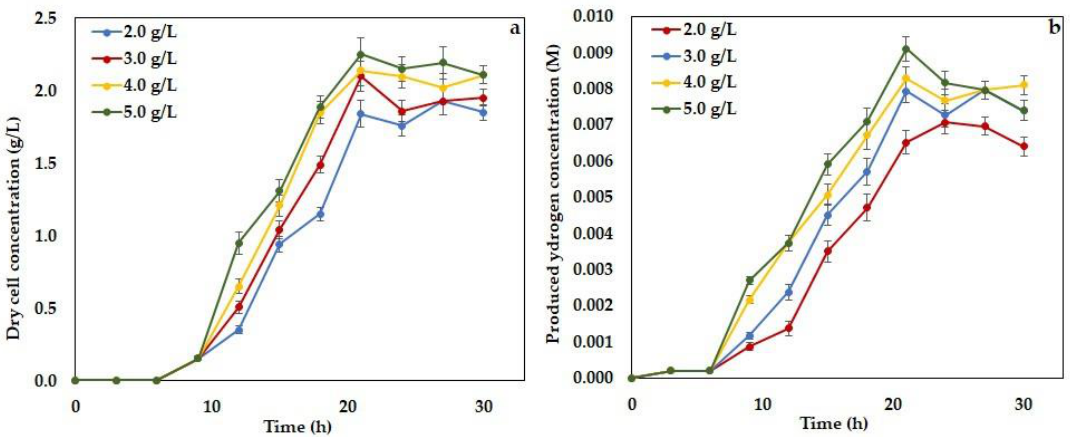
Figure 7. Experimental time histories of dry cell concentration ( a ) and hydrogen concentration ( b ) with initial 20% H 2 in reactor headspace at different substrate concentration.